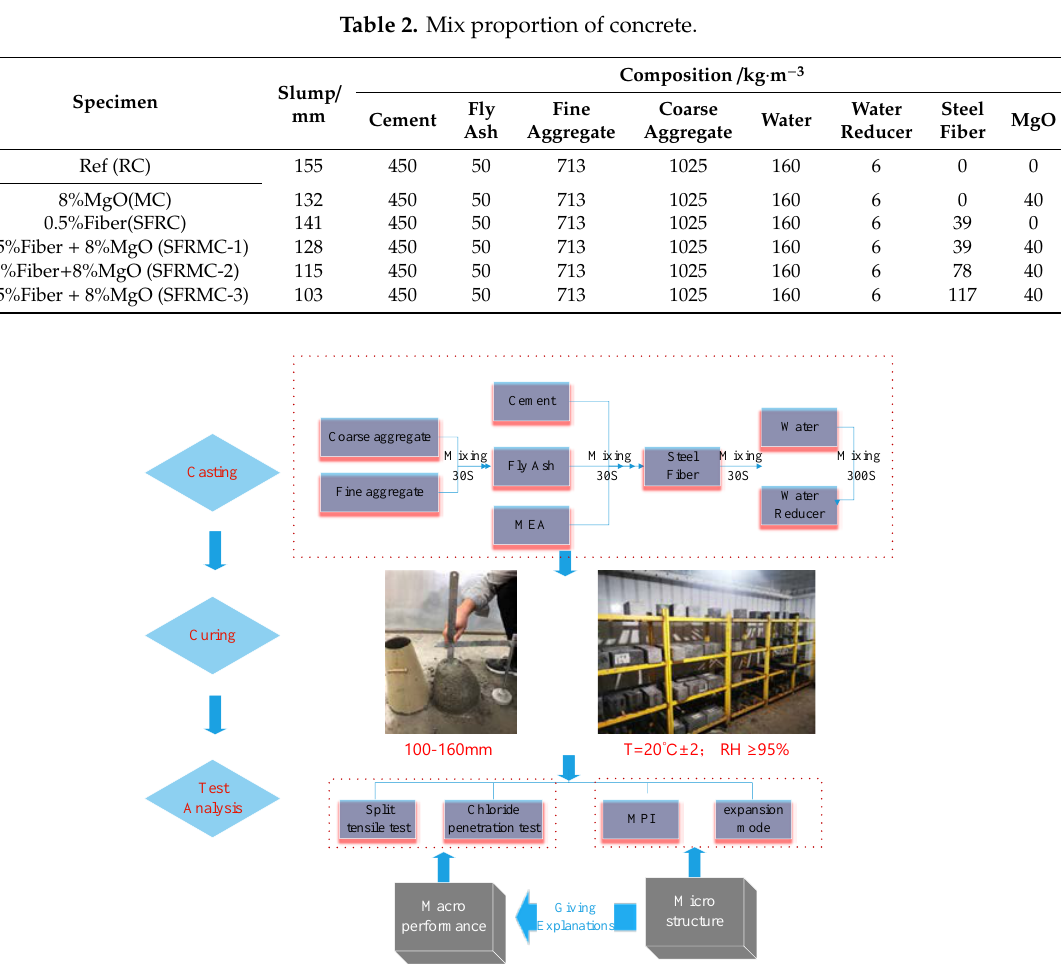
Figure 3. The specific process and analysis method.